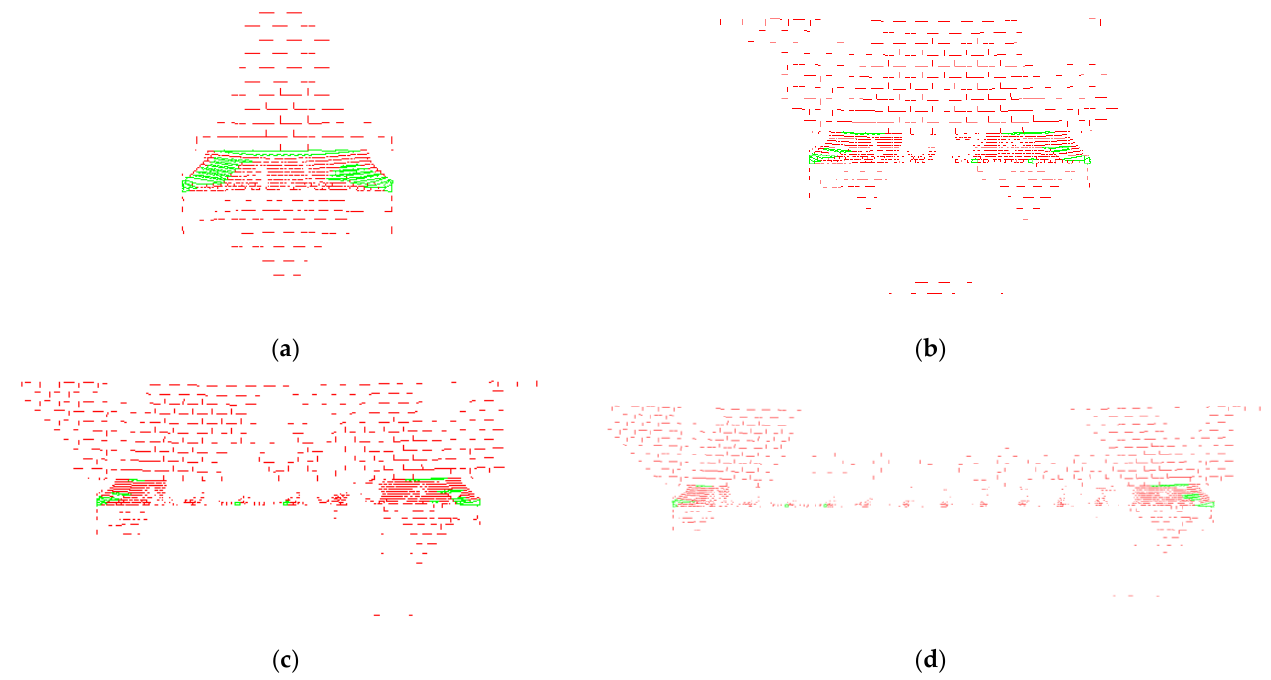
Figure 5. Evolution of roof cracks when working face advances at different distances: ( a ) evolution of roof cracks when working face advances at 30 m; ( b ) evolution of roof cracks when working face advances at 50 m; ( c ) evolution of roof cracks when working face advances at 80 m; and ( d ) evolution of roof cracks when working face advances at 140 m.